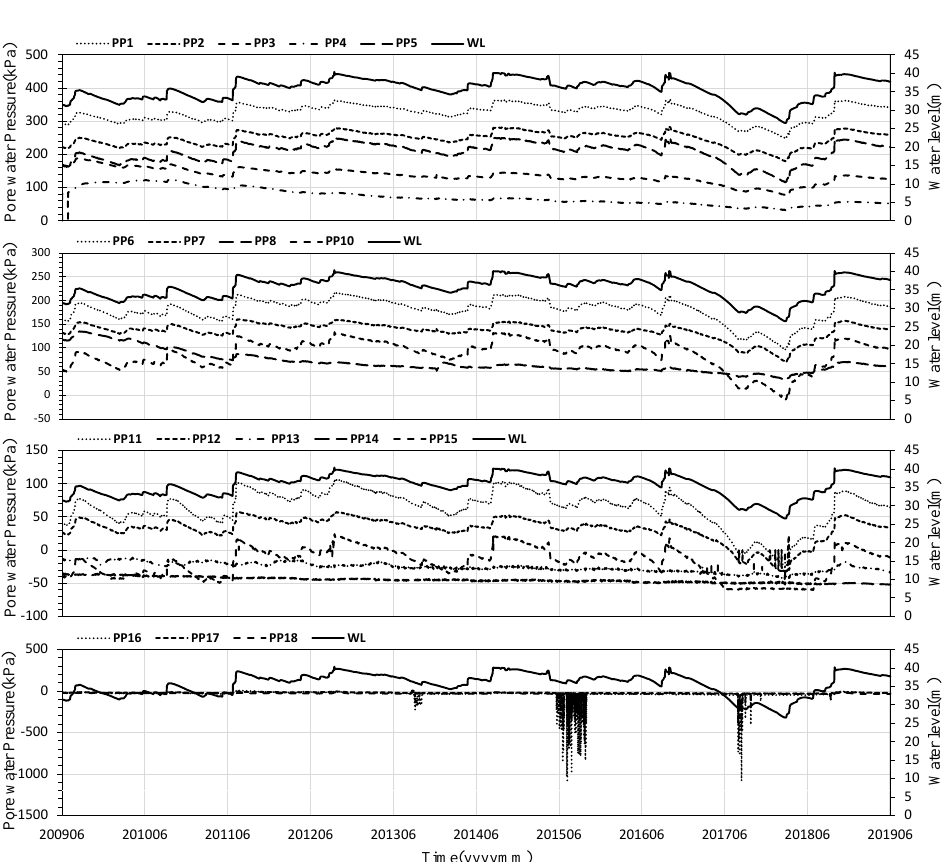
Figure 4. Relationship between porewater pressure and water level.